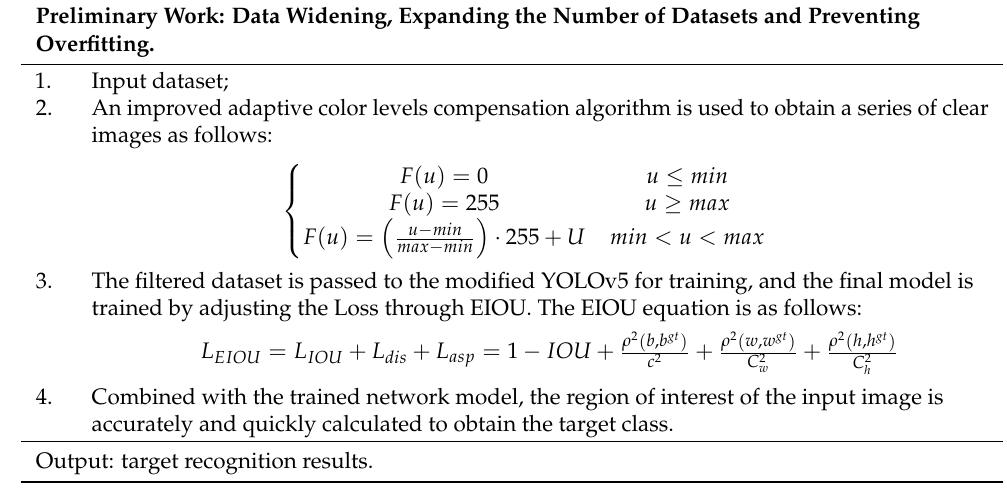
Table 2. Algorithm